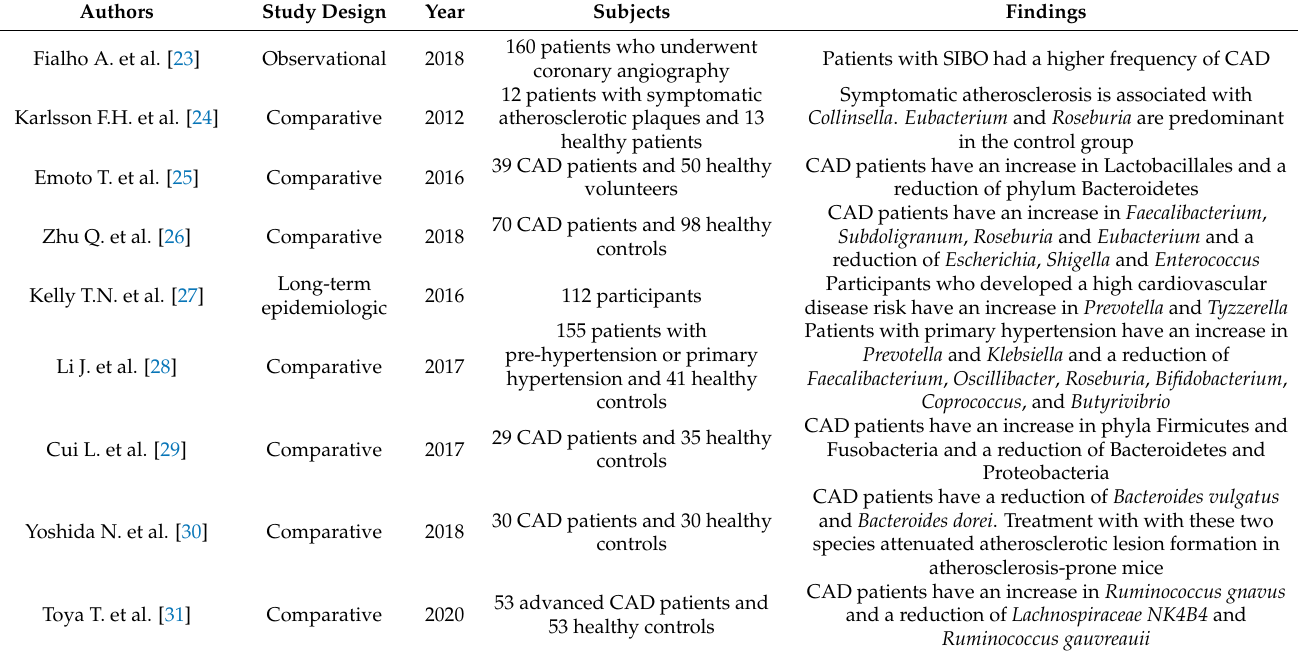
Table 1. Studies on gut microbiota composition in CAD patients.